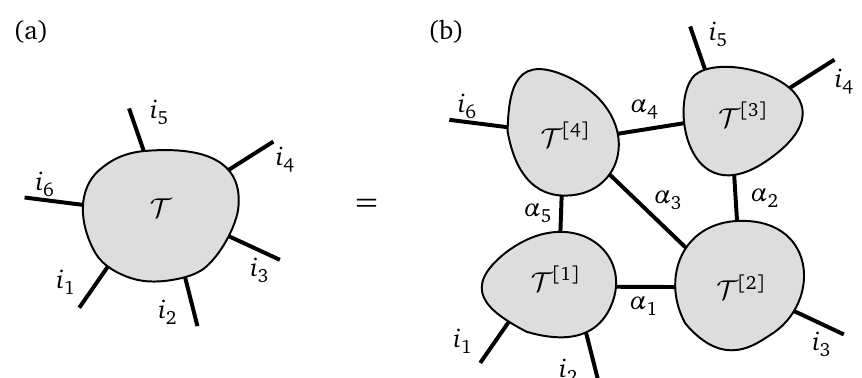
Figure 2: (a) The coefficients of a QMB wave function (here with N = 6 constituents) can be understood as the elements of a tensor T with N links. Graphically, we represent a tensor by a circle-like object (node) with an open link for every physical site s . Fixing the indices i for all links s then identifies the element T . (b) A s i 1 ... i N possible TN decomposition of the system: The state is now represented by Q = 4 smaller tensors T [ q ] , which are connected through L = 5 auxiliary links. The original tensor object is obtained once again by contracting tensors over shared indices, which are represented by the links connecting them. For a detailed introduction to the graphical notation, see Sec.